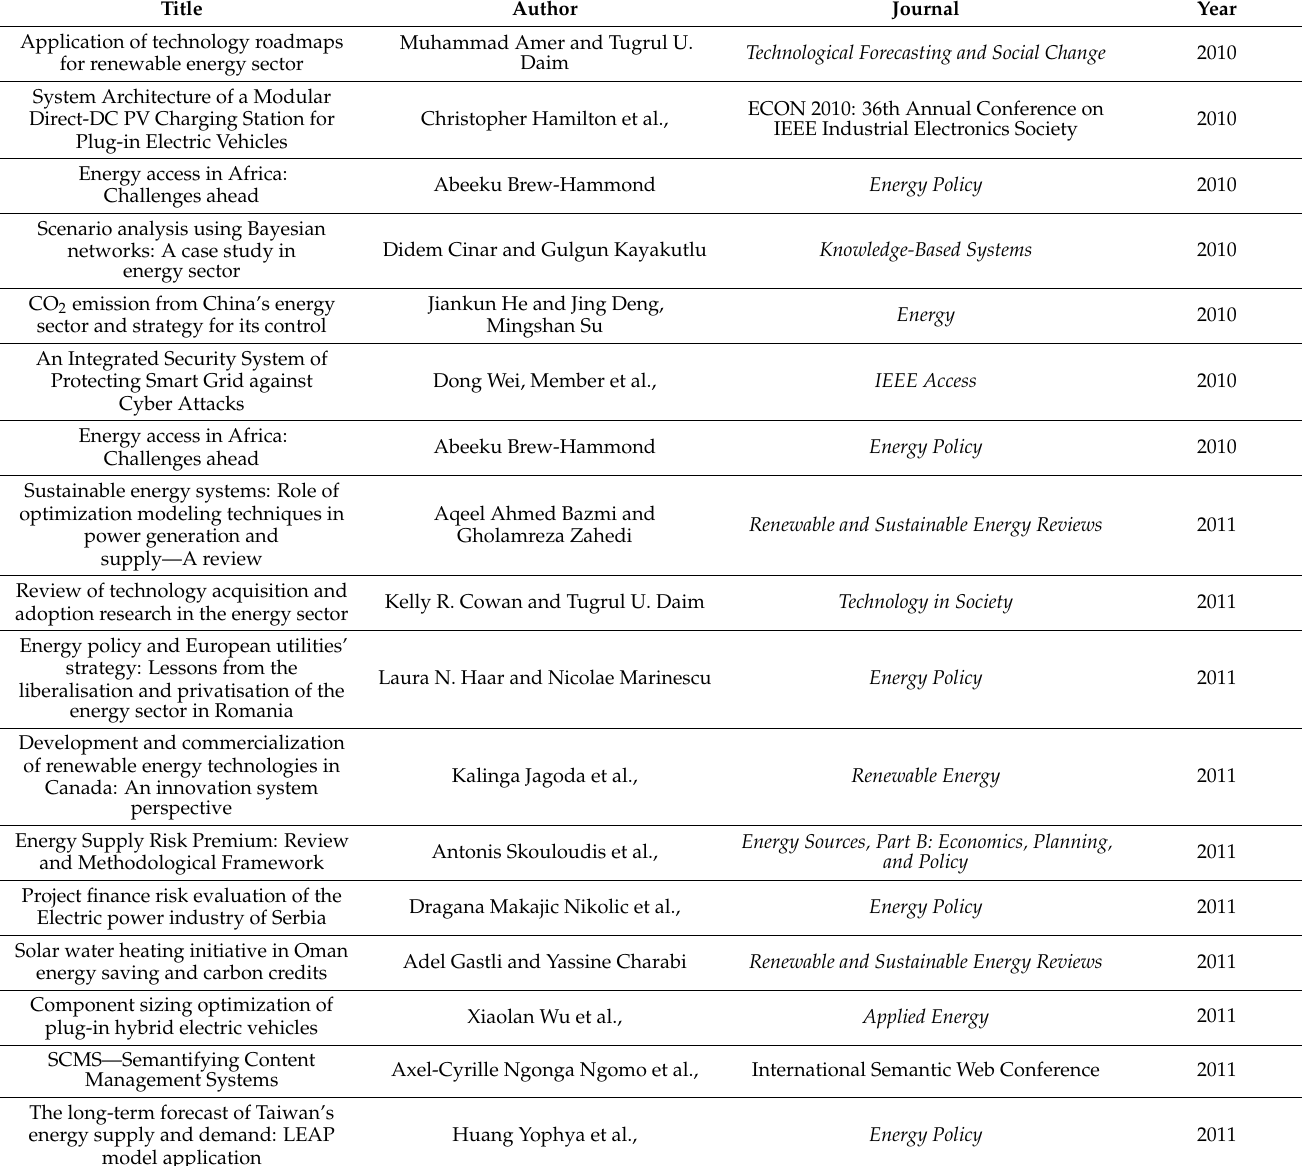
Table A1. List of analyzed texts (in chronological order). Source: own study.